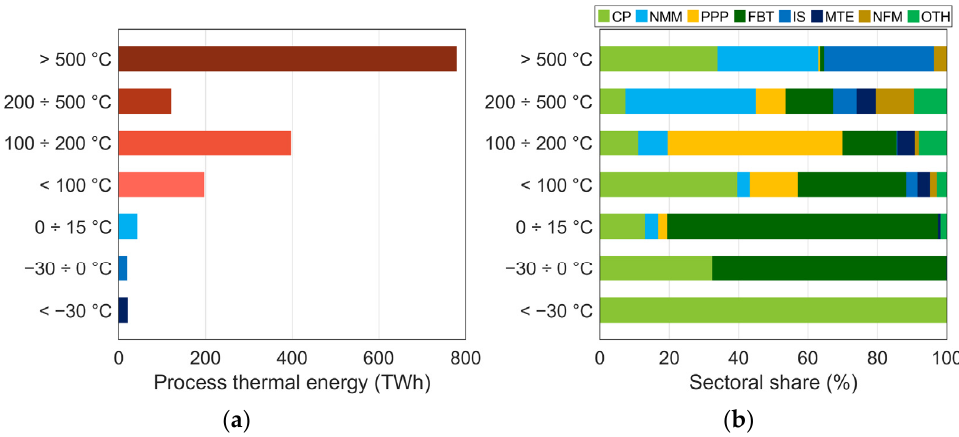
Figure 3. Process thermal energy: ( a ) temperature level distribution; ( b ) sectoral breakdown. Based on data from [26].